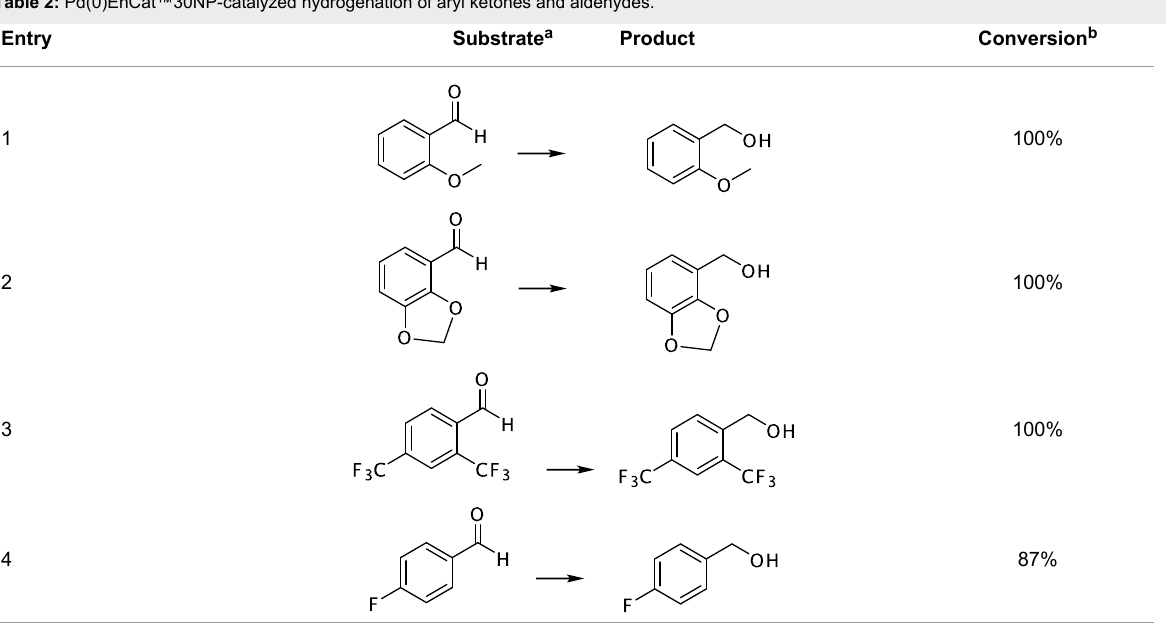
Table 3: Pd(0)EnCat™ 30NP-Catalyzed Hydrogenolysis of trans-stilbene oxide. Comparison with other Pd catalysts.